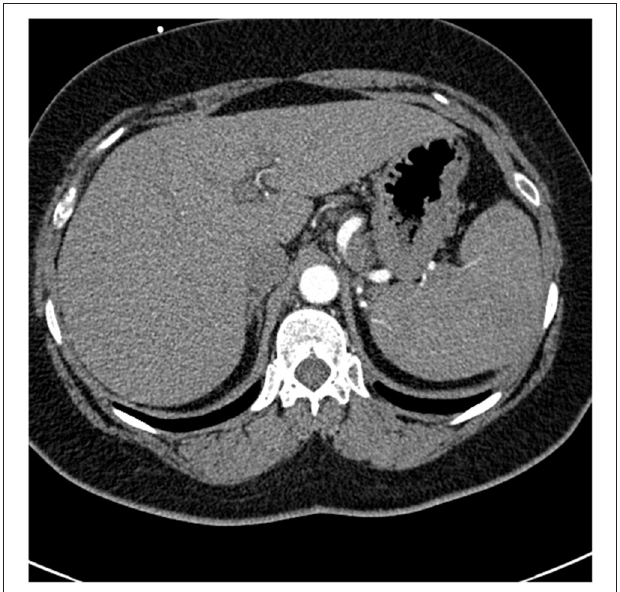
FIGURE 8 | A lower chest CT scan image from the same scan as Figure 5 showing a mildly enlarged spleen, which is a common feature with common variable immunodeficiency.